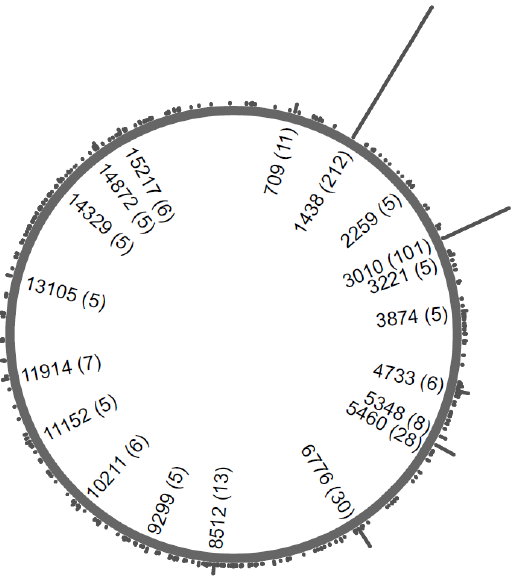
Figure 4. Circular histogram of the variation found in the 216 Italian mitogenomes harboring the most common West Eurasian CR haplotype. Labels were added to nps of the mtDNA molecule where five or more occurrences (indicated in brackets) were observed. Universal variants present in all 216 mitogenomes are not depicted (see text and Table S1 for details).